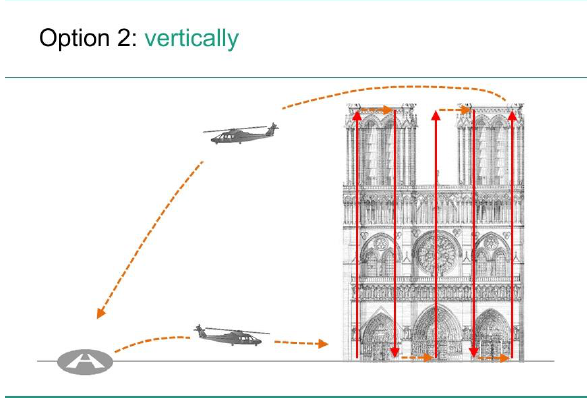
Figure 3. Vertically aligned building flight